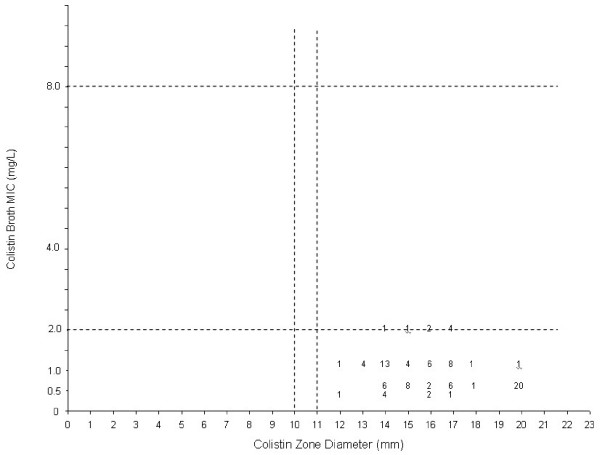
Comparative results between broth microdilution MICs and 10-μg disc zone diameters for Colistin tested against 78 carbapenem-resistant P. aeruginosa isolates. The broken lines represent the breakpoint values for Polymyxin E by disc diffusion method [10].